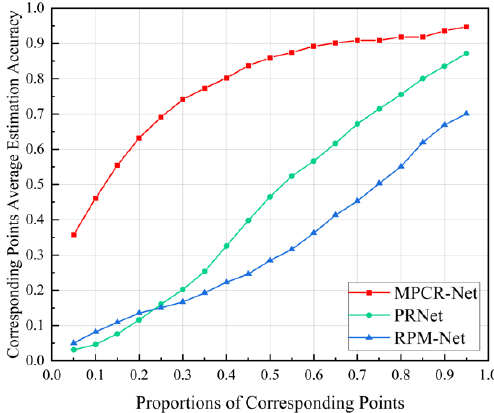
Figure 9. Average estimation accuracy of correspondence points with different proportions of correspondence points.